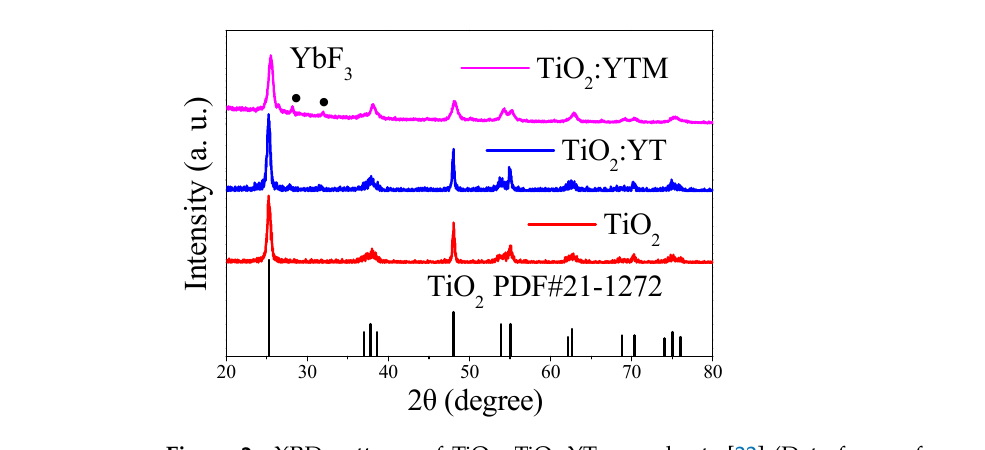
Figure 2. XRD patterns of TiO 2 , TiO 2 :YT nanosheets [22] (Date from reference [22]) and TiO 2 :YTM nanospheres.